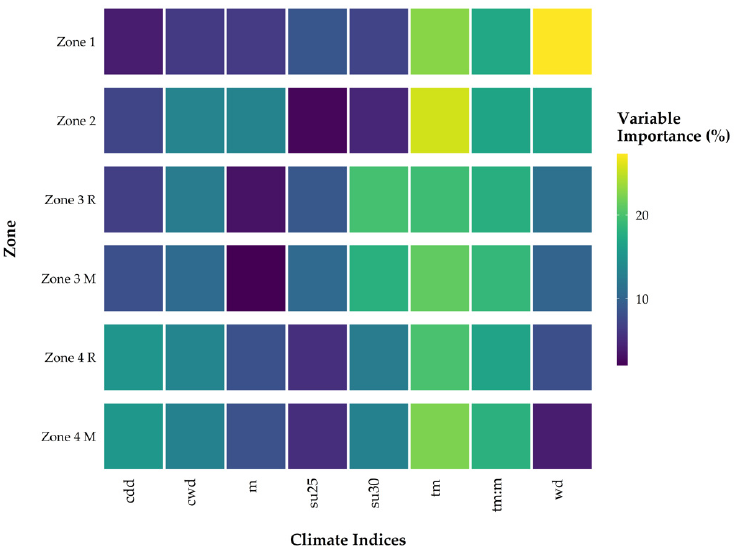
Figure 4. Variable importance GMLR model for each zone. The color gradations represent the variable importance of the GMLR model of each zone. The brighter the box the more important is the variable in the corresponding zone; consecutive dry days (cdd), consecutive wet days (cwd), month (m), summer days (su25), hot days (su30), air temperature (tm) and days of the week